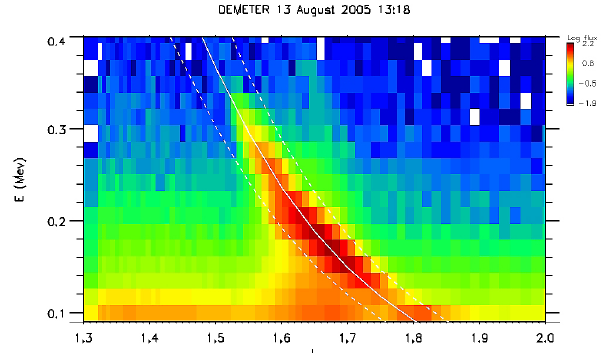
Fig. 3. Electron energy L spectrogram for the structure recorded on 13 August 2005 starting at 13:18UT. The white line is the result of the computation of wave-particle interaction described in the text. The dashed lines are for a plasmaspheric plasma density enhanced (lower curve) and divided by a factor 1.3 (upper